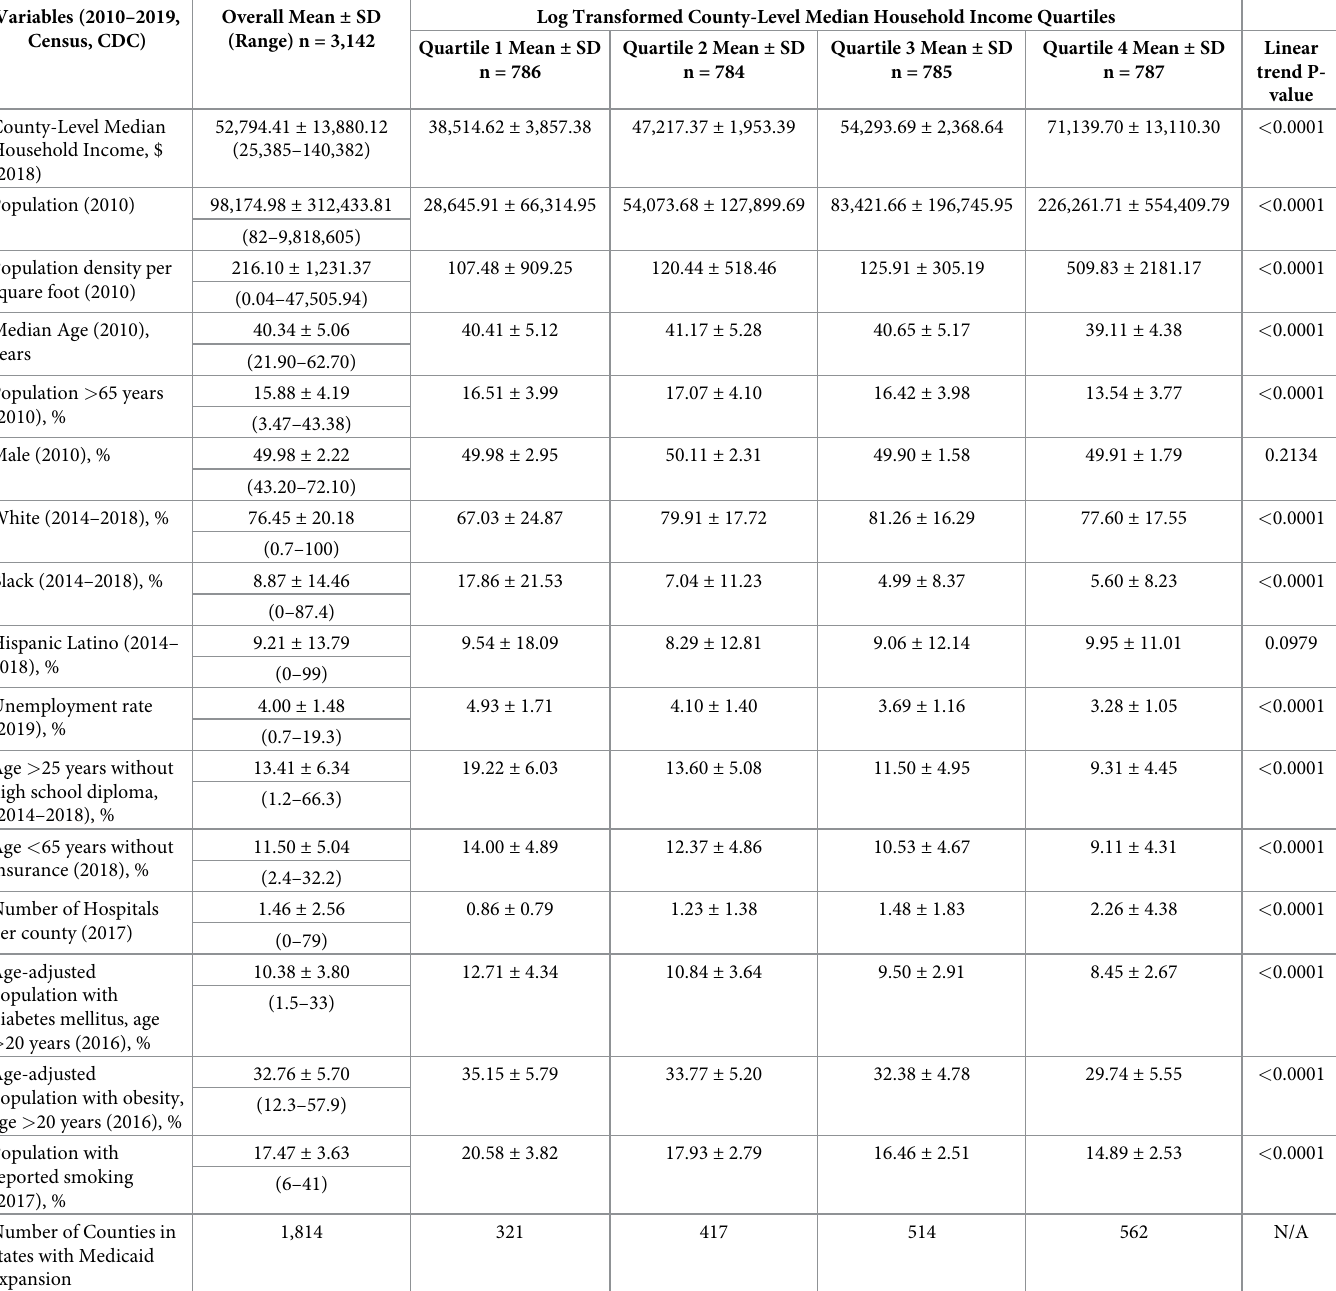
Table 1. Counties baseline characteristics by log transformed county-level median household